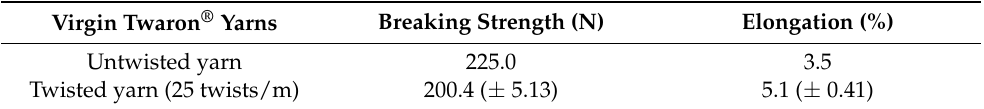
Table 1. Mechanical properties of Virgin Twaron ® yarns (from the data sheet) and Virgin Twaron ® yarns twisted (experimental